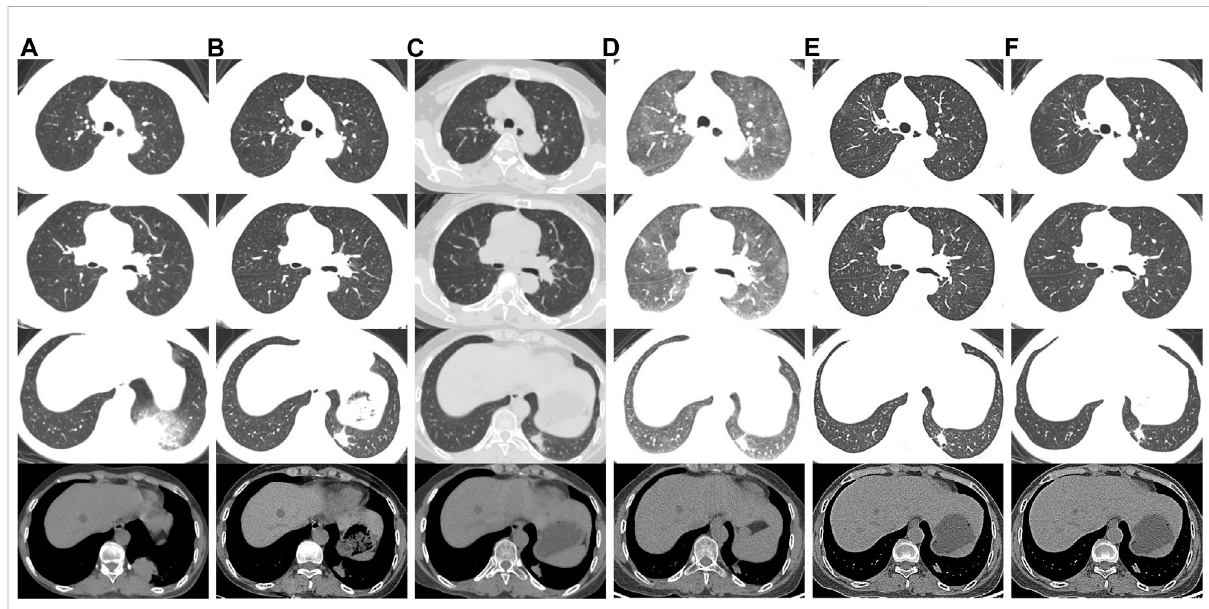
FIGURE 1 Chest CT scans of the patient . (A) Scans performed before alectinib therapy. (B) On the 30th day of alectinib therapy, chest CT showed tumor shrinkage. (C) Onthe102nddayafteralectinibtherapy,chestCTshowedscatteredGGOsinvolvingbothlungsandtumorshrinkage. (D) Onthe185th day of alectinib therapy, chest CT showed diffuse GGOs involving both lungs. (E) GGOs gradually improved after discontinuation of alectinib. (F) At the latest follow-up (2 months later), chest CT showed no recurrence of interstitial lung